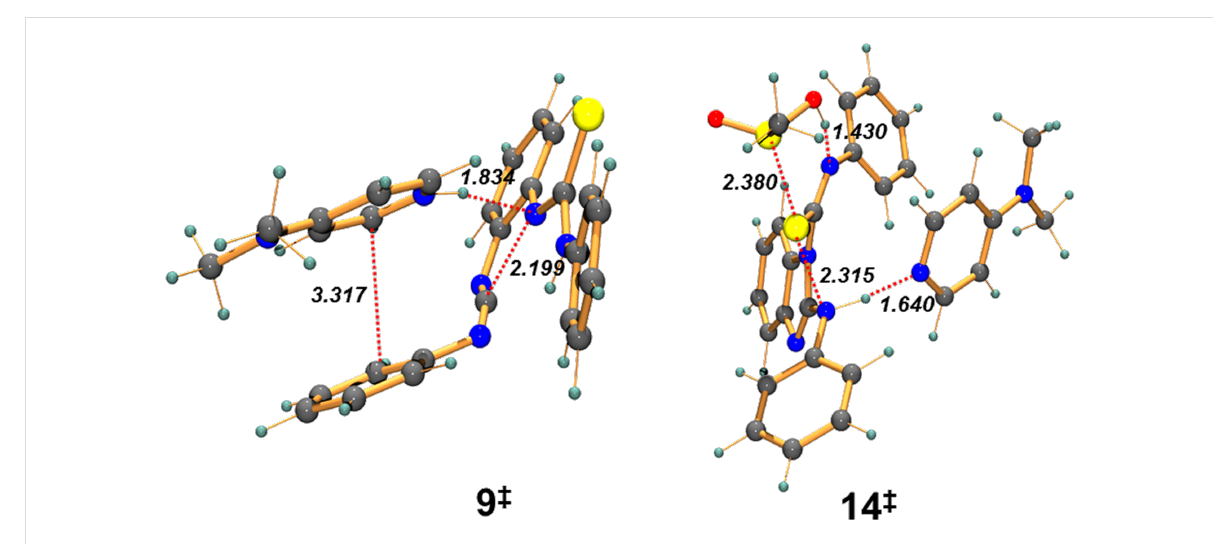
Figure 3: Optimized geometries of 9 ‡ and 14 ‡ . Distances are shown in angstrom